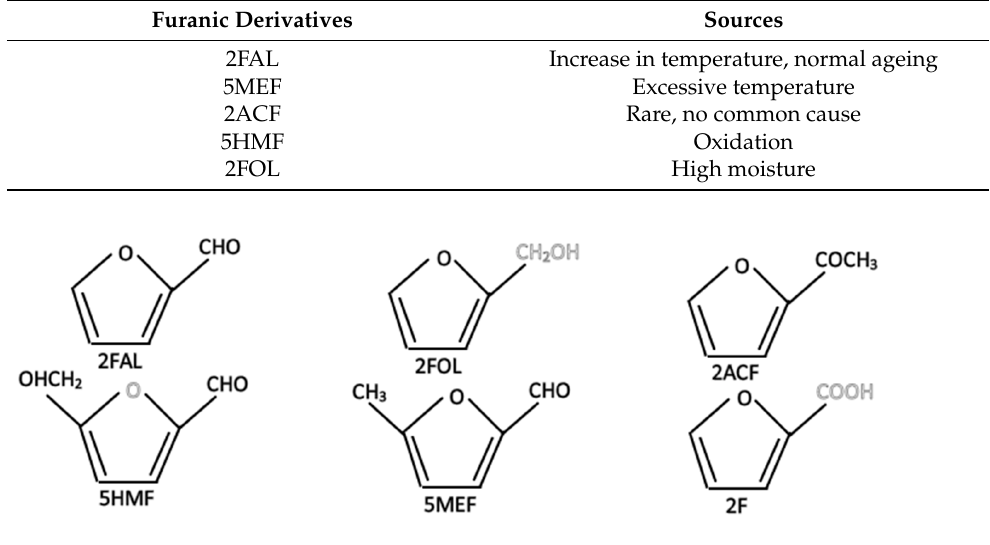
Figure 4. Chemical structure of furan derivatives.